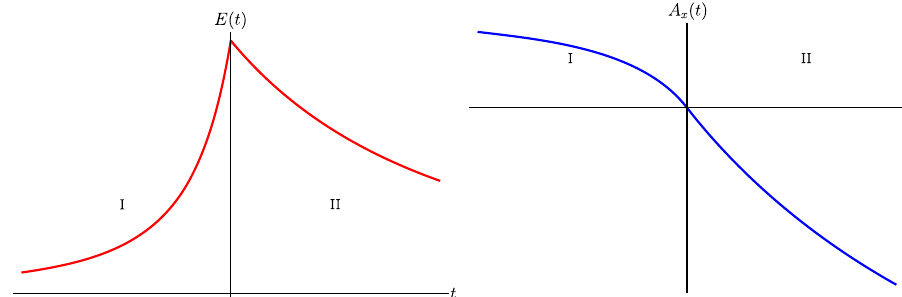
Fig. 1 The electric field (left panel – red lines) and its potential (right panel – blue lines) for some pulse durations τ j and a fixed amplitude E . In both pictures, τ 1 < τ